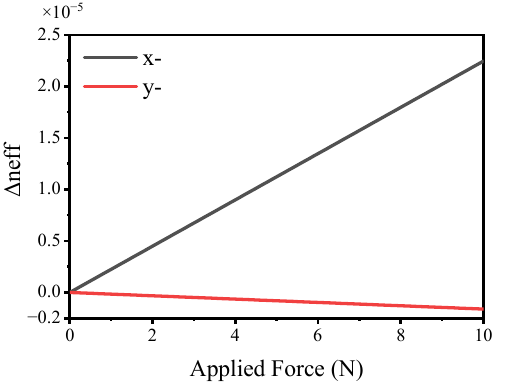
Figure 1. Relationship between change in refractive index and applied force under transverse stress.